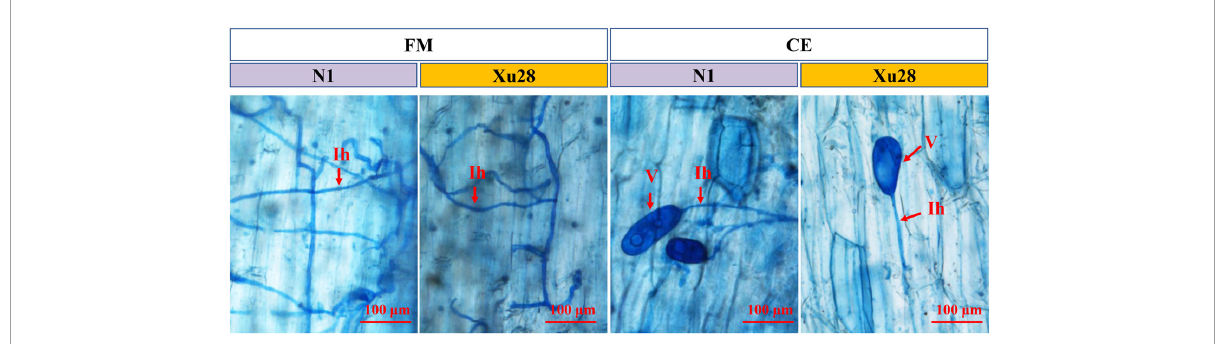
FIGURE1 Microscopic visualization of arbuscular mycorrhizal fungi structures in root of sweet potato at seeding stage. “N1” and “Xu28” indicate “sweet potato “N1”” and “sweet potato “Xu28””, respectively. “FM” and “CE” indicate “ Funneliformis mosseae ” and “ Claroideoglomus etunicatum ”, respectively. Red arrows indicate different arbuscular mycorrhizal fungi (AMF) structures. Ih, intraradical hyphae; V, vesicle.